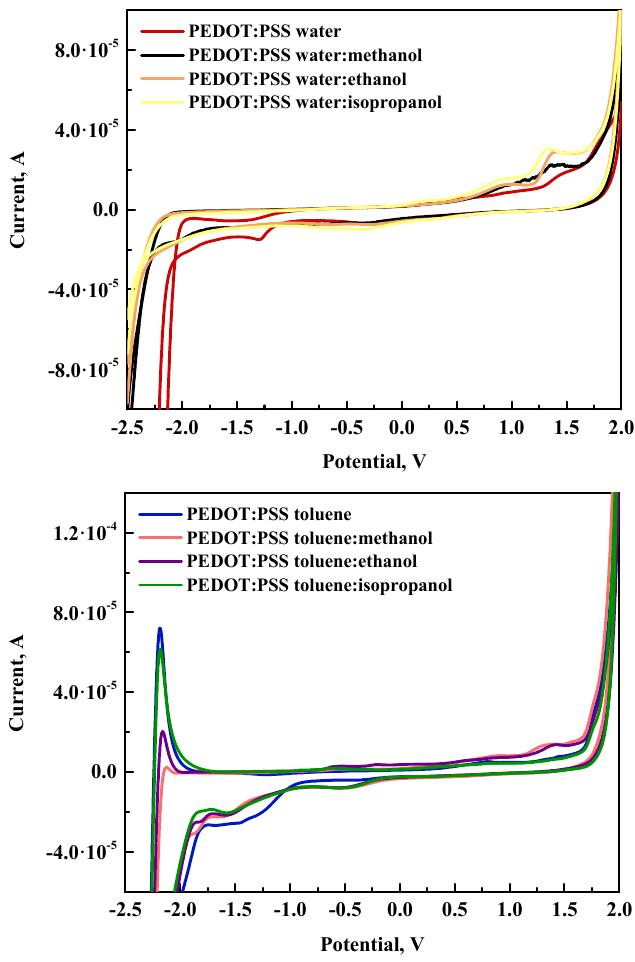
Figure 5. Comparative cyclic voltammetry (CV) curves for PEDOT:PSS in water (top) and toluene (bottom).